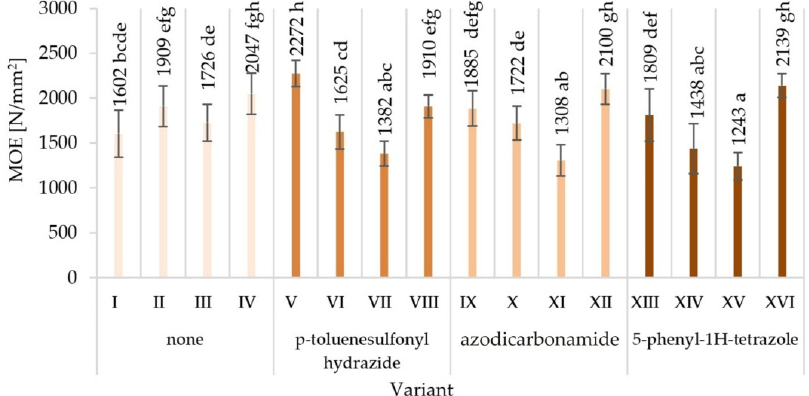
Figure 3. Static bending strength ( MOR) of particleboards produced (means and standard devia- tion, a, b, c, …—homogeneous groups determined by the Tukey test; different letters denote a sig- nificant difference; means followed by the same letter do not statistically differ from each other).